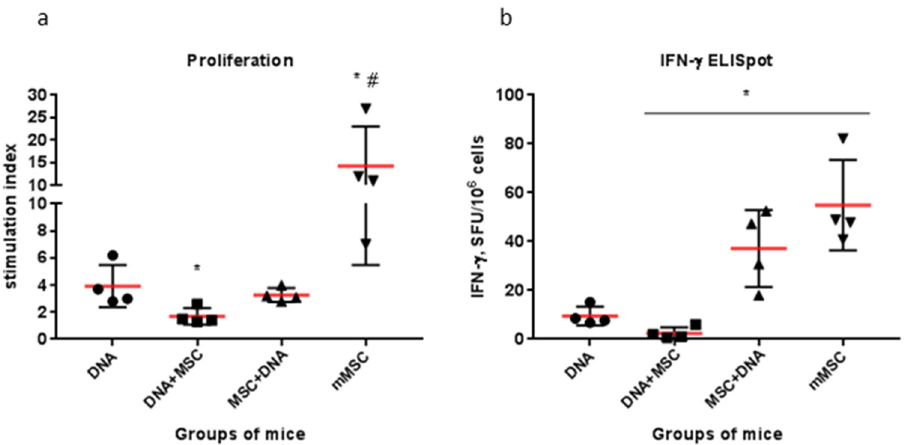
Figure 6. Comparative efficacy of the overall mean cellular responses to HCV in different variants of DNA immunization using MSCs. Mice were immunized with pcNS3-NS5B plasmid alone or in various combinations with MSCs. To assess the overall mean cellular response of lymphocytes in vitro to recombinant HCV proteins, we averaged the data obtained for the recombinant proteins from the nonstructural region of HCV, which were combined into four pools (NS3, NS4, NS5A, and NS5B). The overall mean cellular response to HCV proteins in the lymphocyte proliferation reaction ( a ), and in the number of IFN- γ -synthesizing cells by ELISpot ( b ). DNA—naked pcNS3-NS5B plasmid; MSC—naïve MSC; mMSC—genetically modified MSC expressed nonstructural HCV proteins [17]. * p < 0.05 compared to the naked DNA group; # p < 0.05 compared to all groups.